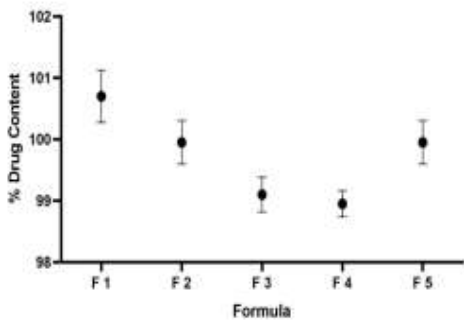
Figure 2. Drug content of sustained-release tablets (mean SD, n=3).